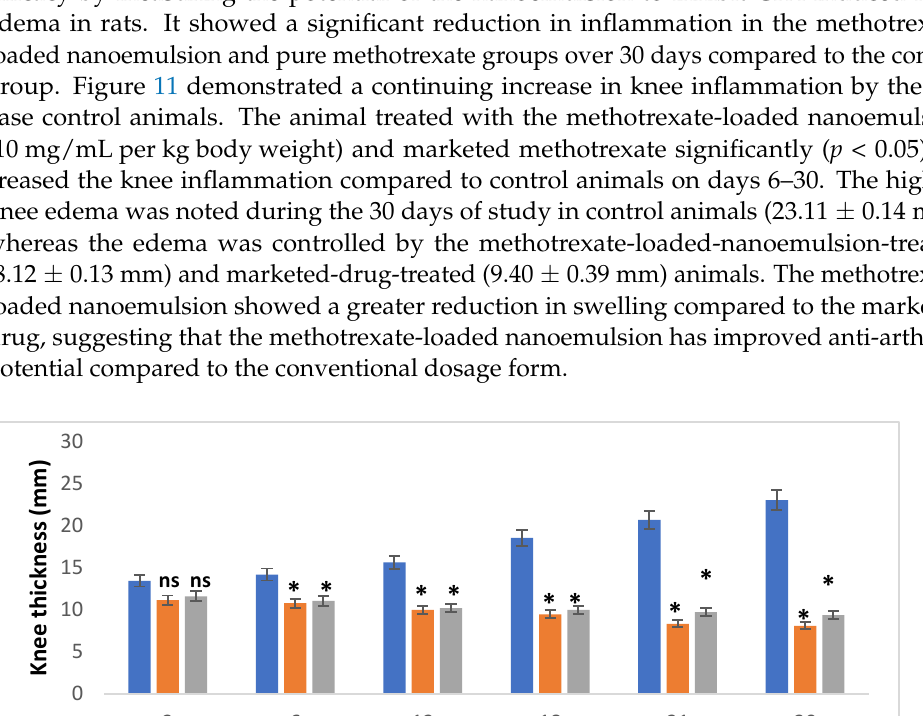
Figure 10. Graphical representation of in vitro cytotoxic effect of methotrexate-loaded nanoemul- sion.